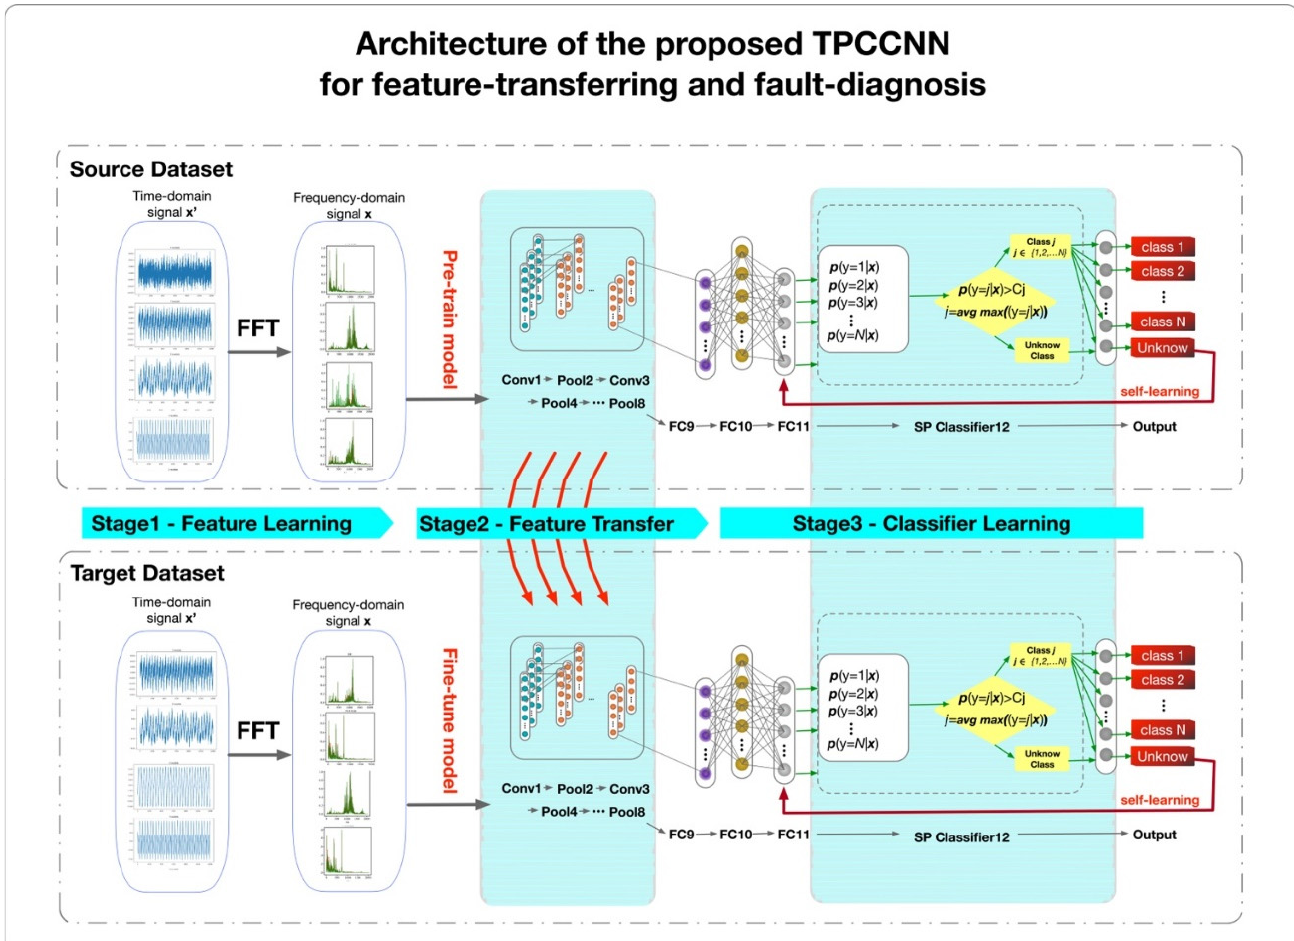
Figure 1. Architecture of the proposed TPCCNN framework.